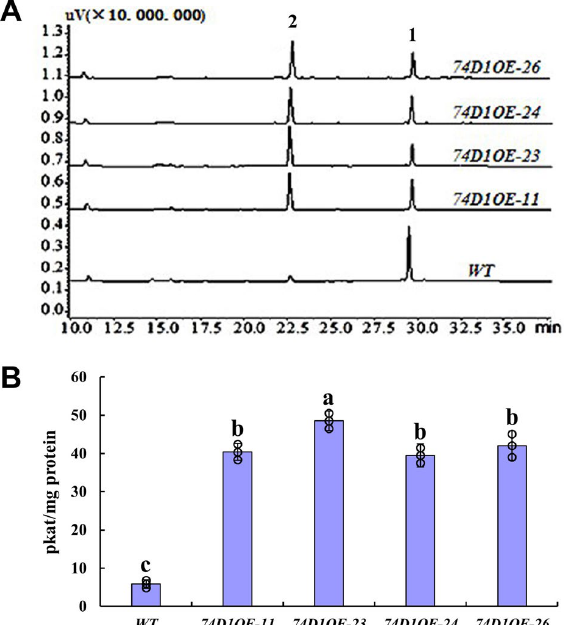
Figure 5. The glucosyltransferase activity of transgenic plants toward IAA. ( A ) HPLC analysis of glucosyltransferase activity of transgenic plants. 1, substrate IAA; 2, glucosyl ester of IAA. ( B ) Calculated activity value of glucosyltransferase activity of transgenic plants. The statistical significance of the difference was confirmed by ANOVA at α = 0.05 level. Error bars indicate SD from triplicate